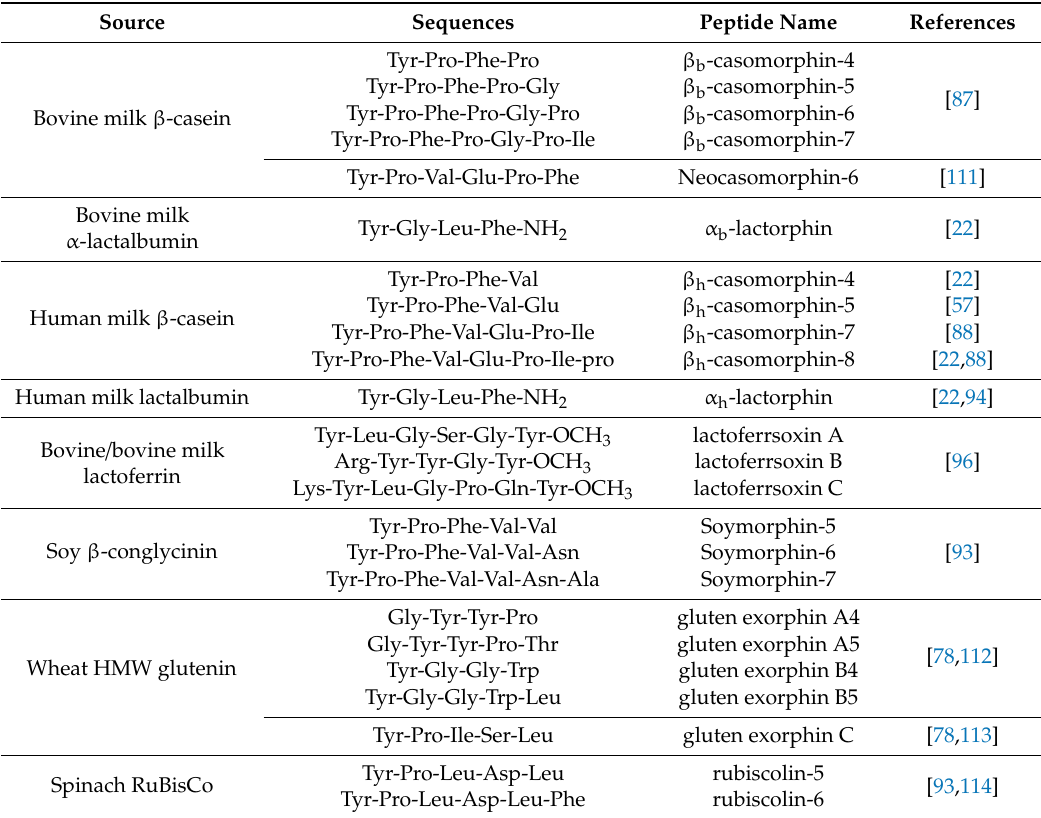
Table 3. Exogenous food-derived opioid peptides.